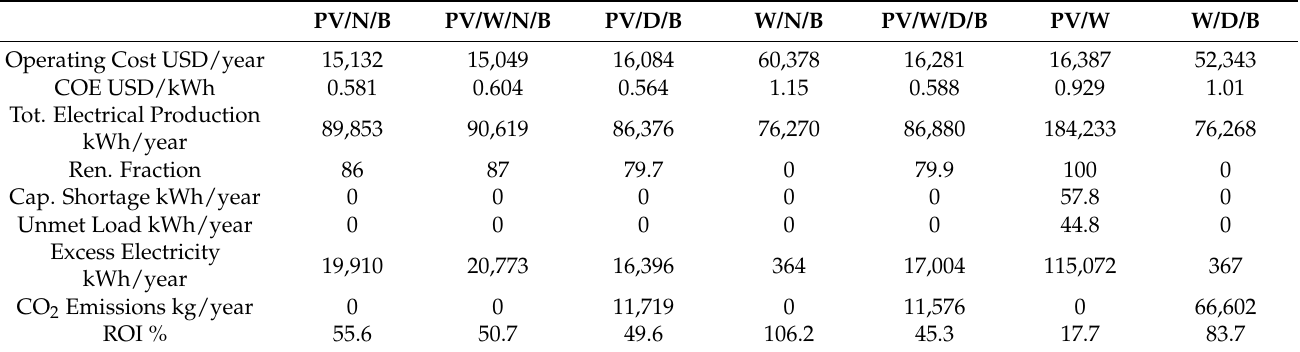
Table 4. Output from HOMER software used to form decision matrix.